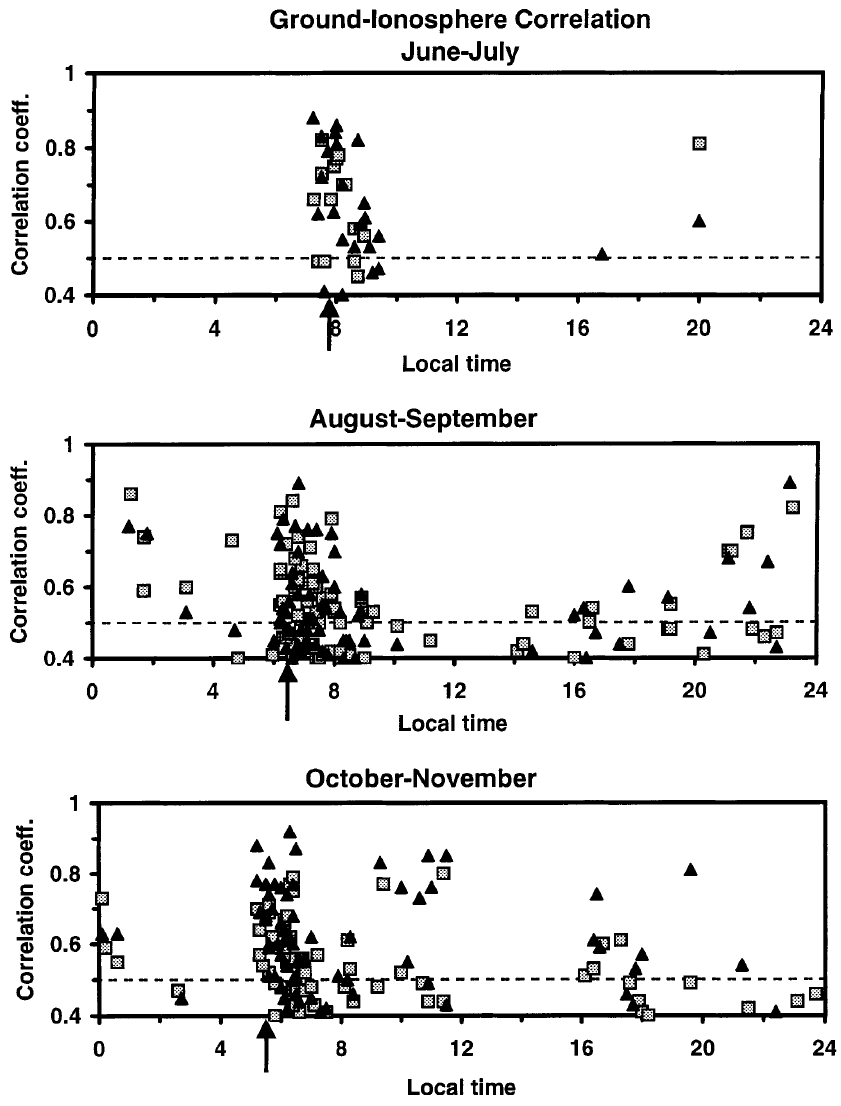
Fig. 3. Correlation coe(cid:129)cients for joint oscillations in the 4 MHz Doppler shift and NS ( squares ) and EW ( triangles ) ground magnetometer components, compared to local time and season. Top panel is for local winter (June/July), middle panel for equi- nox, and bottom panel for late spring/early summer. Arrows